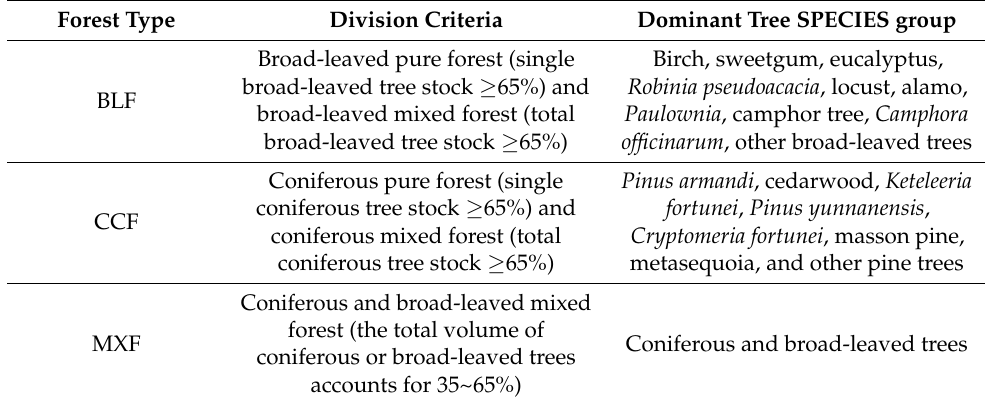
Table A1. The classification basis of forest